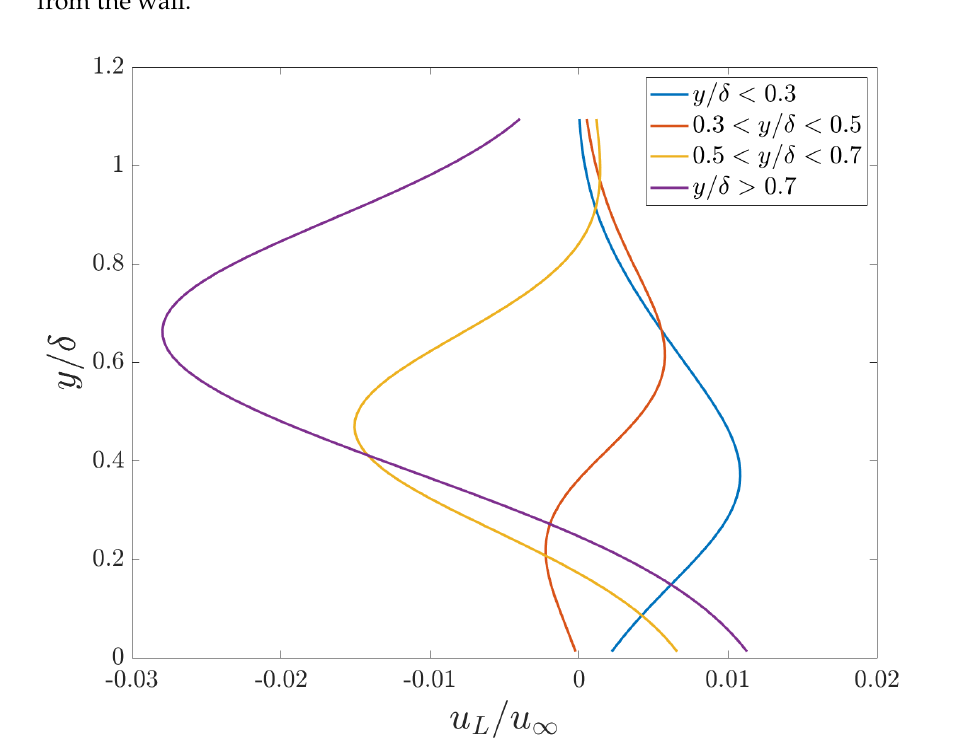
Figure 5. Average fluctuating streamwise large-scale velocity profiles plotted against wall-normal height. Four different ranges of heights of the coherent vortices were used to group the streamwise large-scale velocity data: 0.15 < y v / δ < 0.3 shown in blue, 0.3 < y v / δ < 0.5 shown in red, 0.5 < y v / δ < 0.7 shown in yellow, and y v / δ > 0.7 shown in